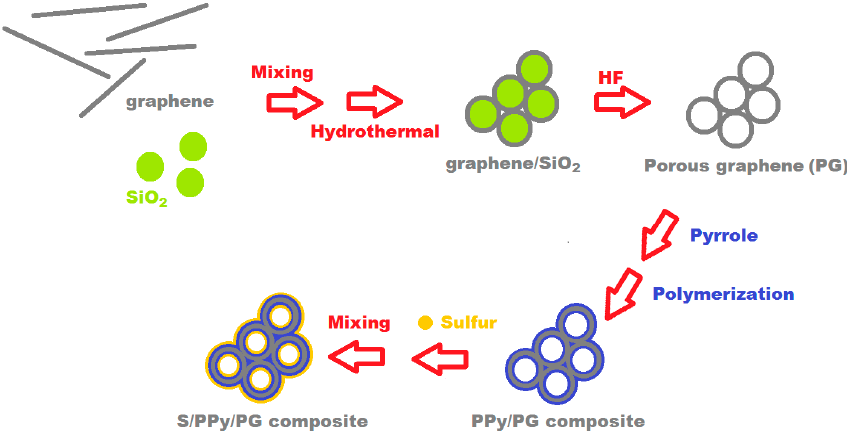
Figure 1. Schematic illustration of S/PPy/PG composite fabrication process.